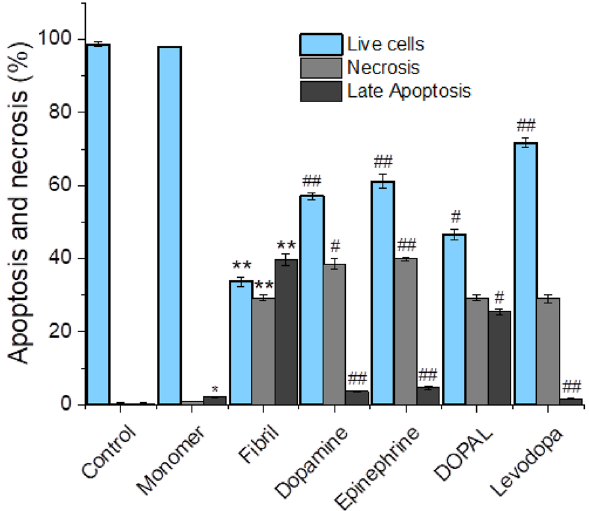
Figure 7. The effect of catechols on the α-syn aggregates-induced cell death in SH-SY5Y cell evaluated by flow cytometry. The percentages of live cells, late apoptotic and necrotic cells after 24 h post-treatment. All tested catechols, except DOPAL, were able to attenuate significantly toxicity related to α-syn amyloid fibrils via decreasing the α-syn amyloid fibril-induced apoptotic cell death. Data are expressed as mean ± SD with n = 3. * p < 0.05, ** p < 0.01 significantly different from control cells. # p < 0.05, ## p < 0.01 significantly different from cells exposed only to α-syn amyloid